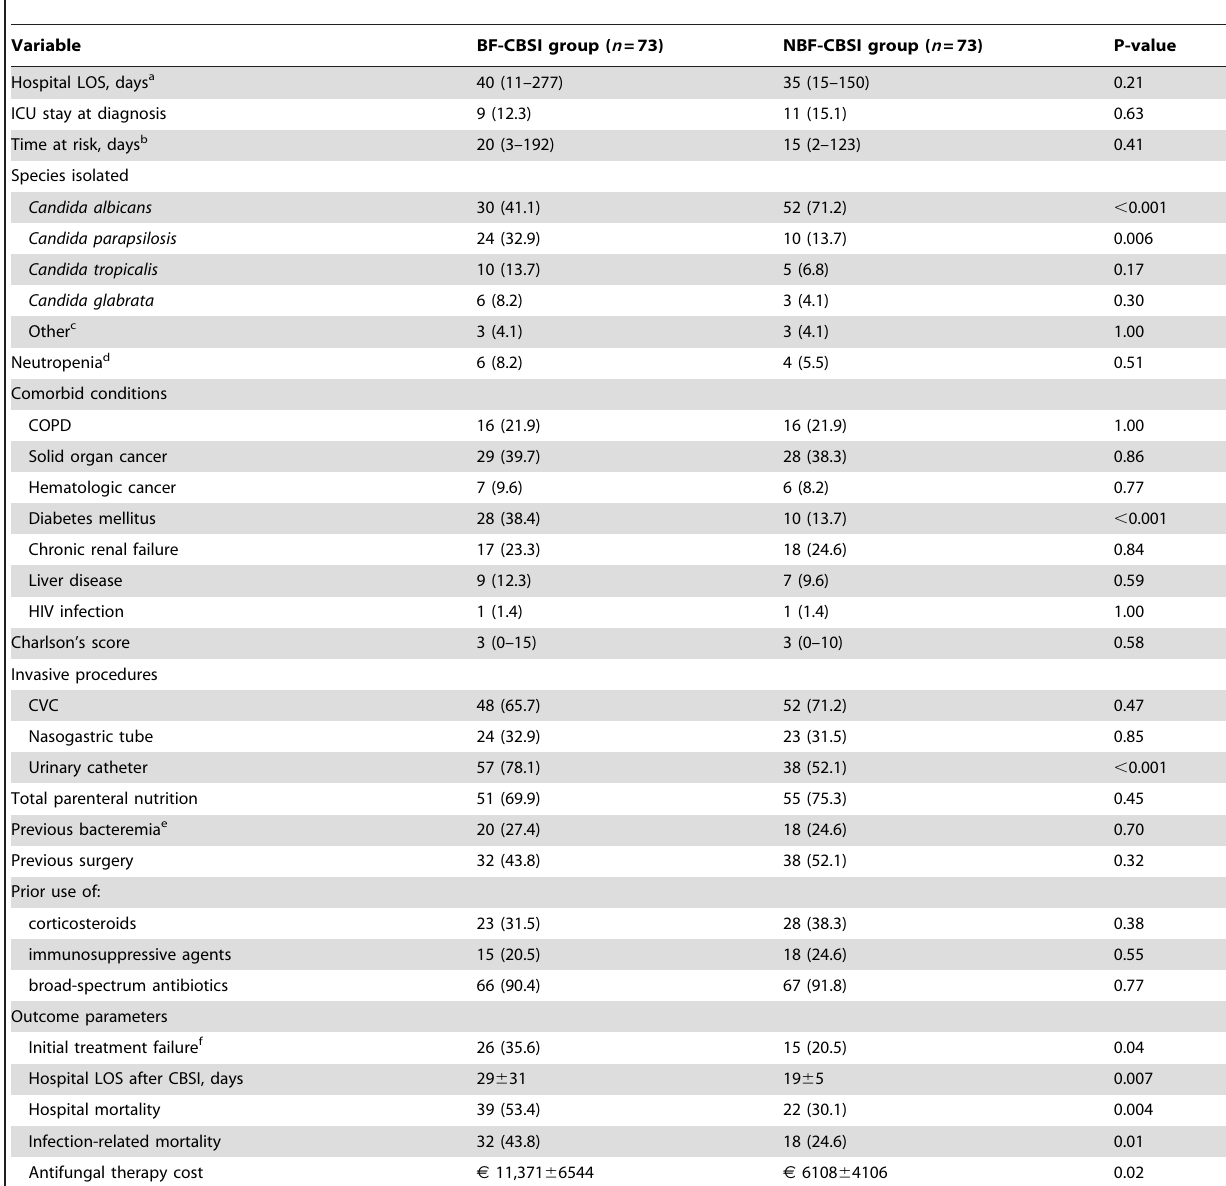
Table 3. Comparison between patients with biofilm-forming (BF) candidemia or non-biofilm-forming (NBF) candidemia in the matched cohort